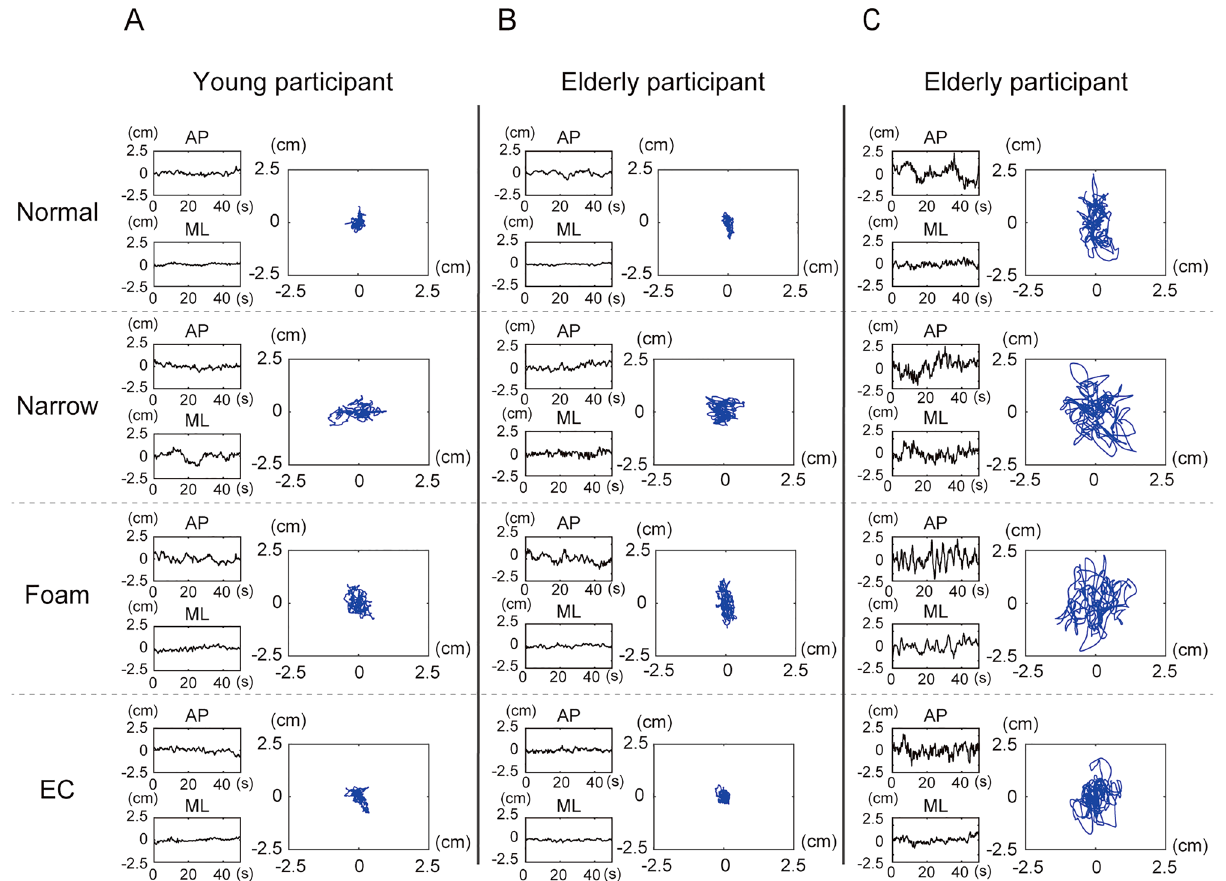
Figure 1. Representative data of time series of the COP displacements in the anteroposterior and mediolateral directions, and the COP trajectories in the planar plane for one young ( A ) and two elderly ( B , C ) participants. Normal: bipedal standing, narrow: standing on narrow base of support, foam: standing on foam rubber, EC: standing with eyes